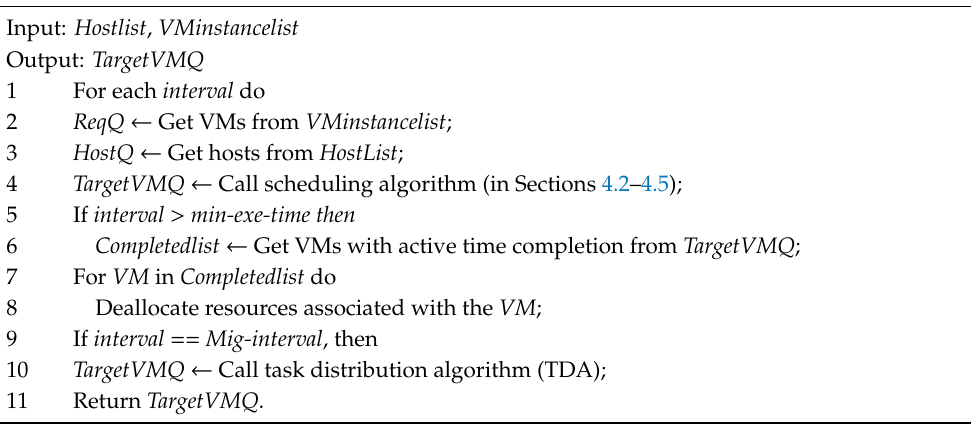
Algorithm 1: High-level overview of ARM algorithm